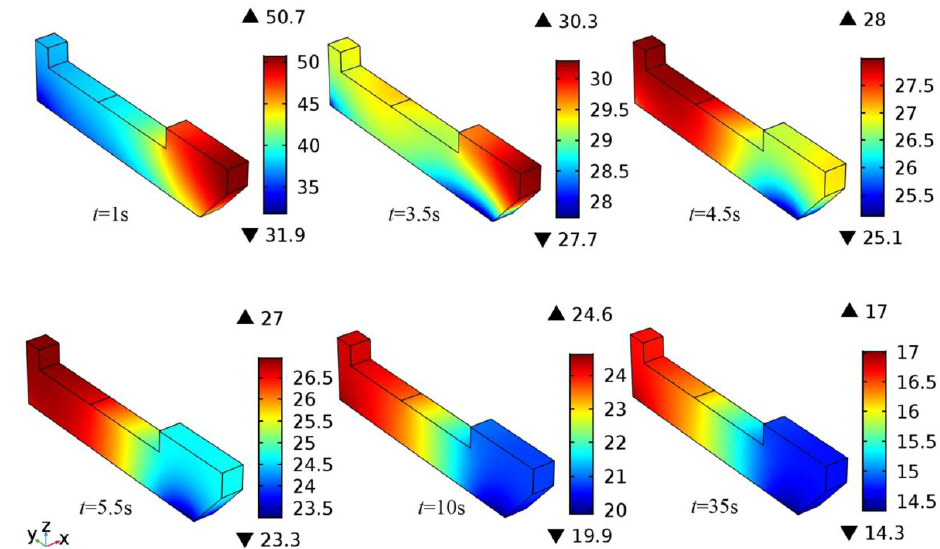
Figure 9. The heat transfer process of a copper bond.